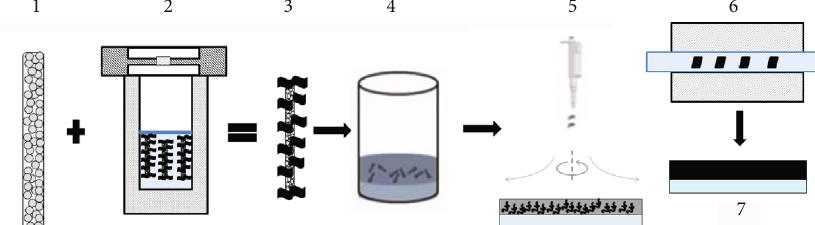
Figure 1: Scheme of process followed to prepare the heterostructures. 1: synthesis of TiO MoS by a hydrothermal technique, 3: TiO 2 annealed, and 7: the TiO